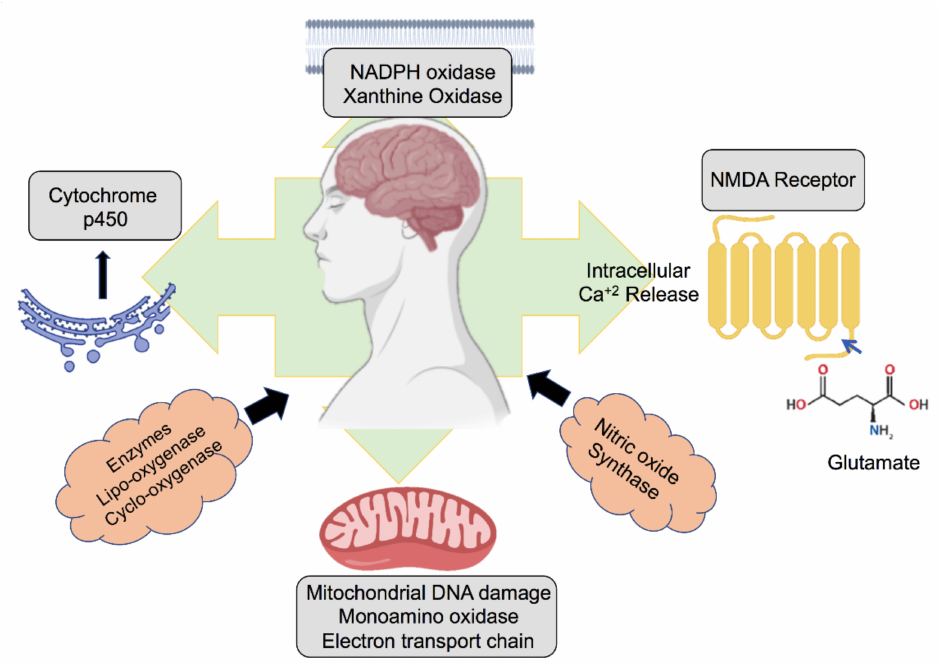
Figure 1. Di ff erent sources of reactive oxygen species (ROS) in the brain and